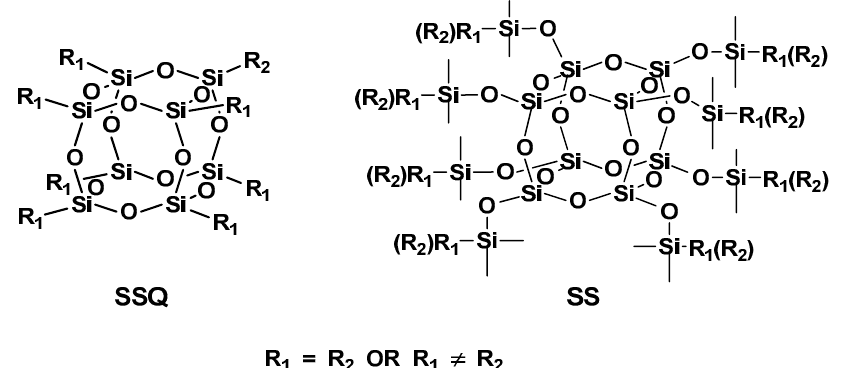
Figure 1. Structure of most common polyhedral oligomeric silsesquioxanes (SSQ) and spherosilicates (SS).